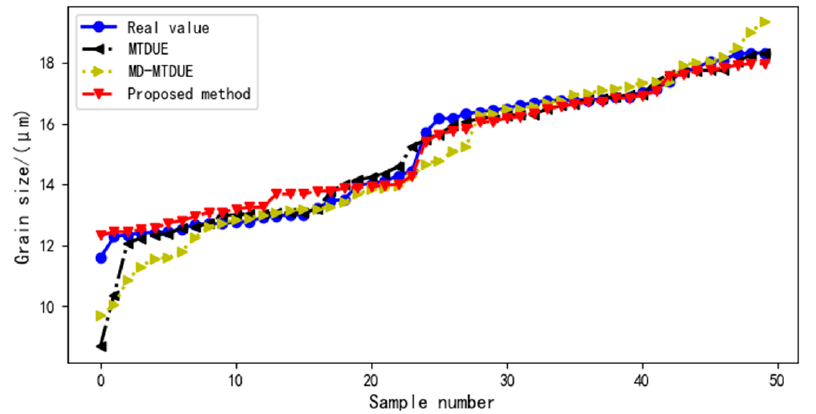
Figure 8. Distribution curve of the test sample value and the predicted value of the test sample in the model.